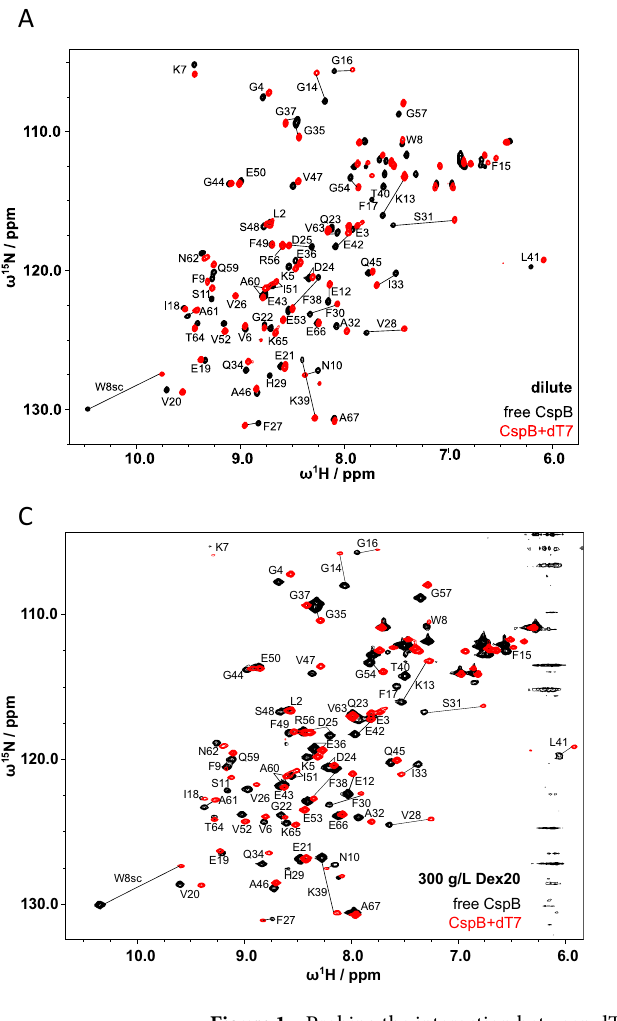
Figure 1. Probing the interaction between dT7 and Bs CspB in absence and presence of a crowded environment by high-resolution NMR spectroscopy. Two-dimensional heteronuclear 1 H– 15 N HSQC spectra comparing free (colored in black) and dT7-bound Bs CspB (colored in red) under dilute conditions ( A ) and in presence of 300 g/L PEG1 ( B ) or 300 g/L Dex20 ( C ). The assignment of backbone signals of Bs CspB is indicated by using the one letter code for amino acids followed by the position in the primary sequence. A twofold molar excess of dT7 regarding Bs CspB has been used to populate the respective ligand-bound state of Bs CspB. Protein concentrations varied between 150 µM (free Bs CspB) and 144 µM ( Bs CspB + dT7). NMR spectra shown in ( A ) and ( B ) have been acquired at T = 298 K, B 0 = 18.8 T, spectra shown in ( C ) have been acquired at T = 294.4 K, B 0 = 14.1 T, respectively. Analysis of chemical shift perturbations (CSPs) is presented as associated data in Fig.